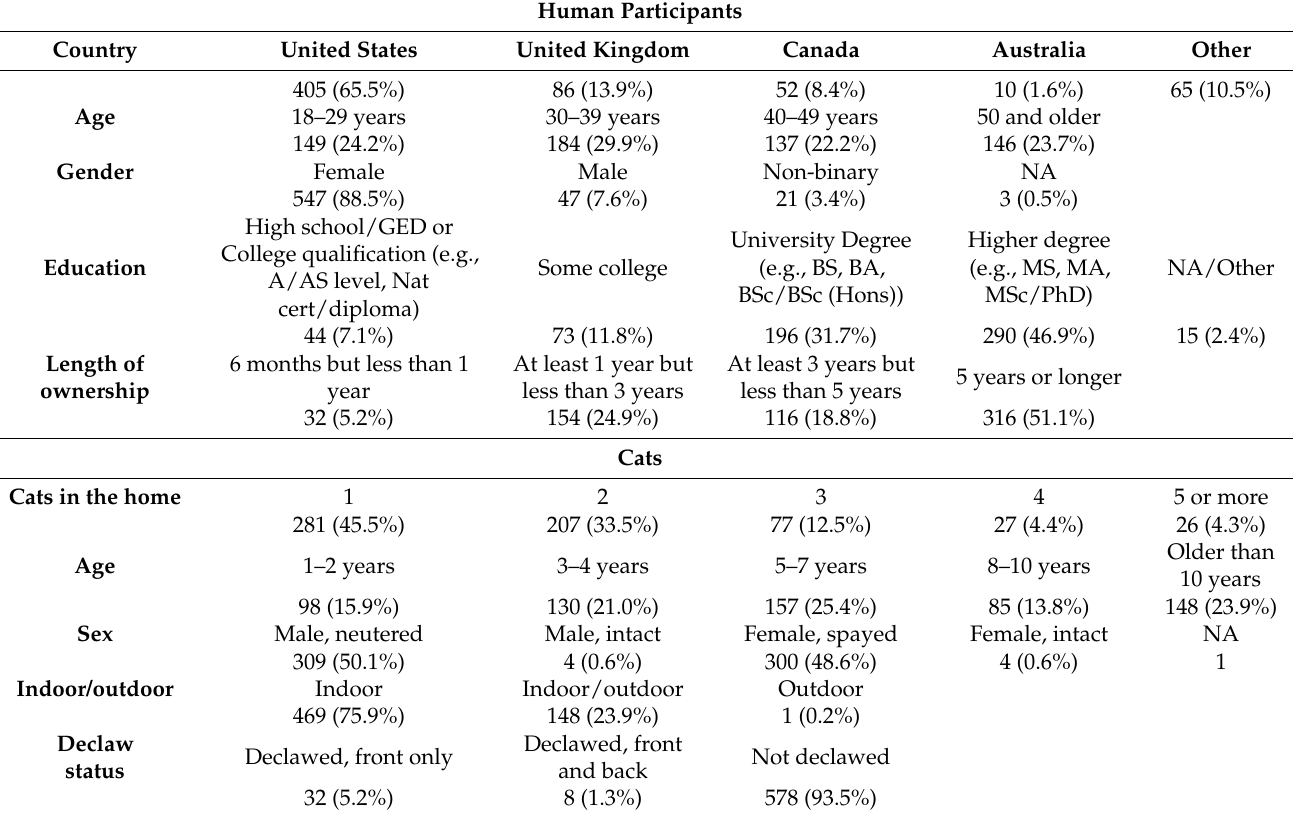
Table 1. Table 1. Demographic data on cat guardians and their cats ( n =